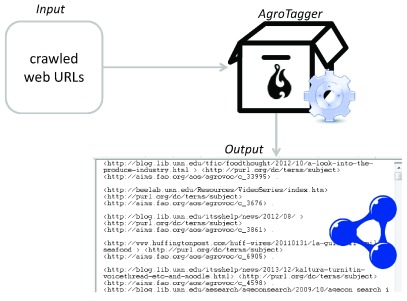
AgroTagger workflow.